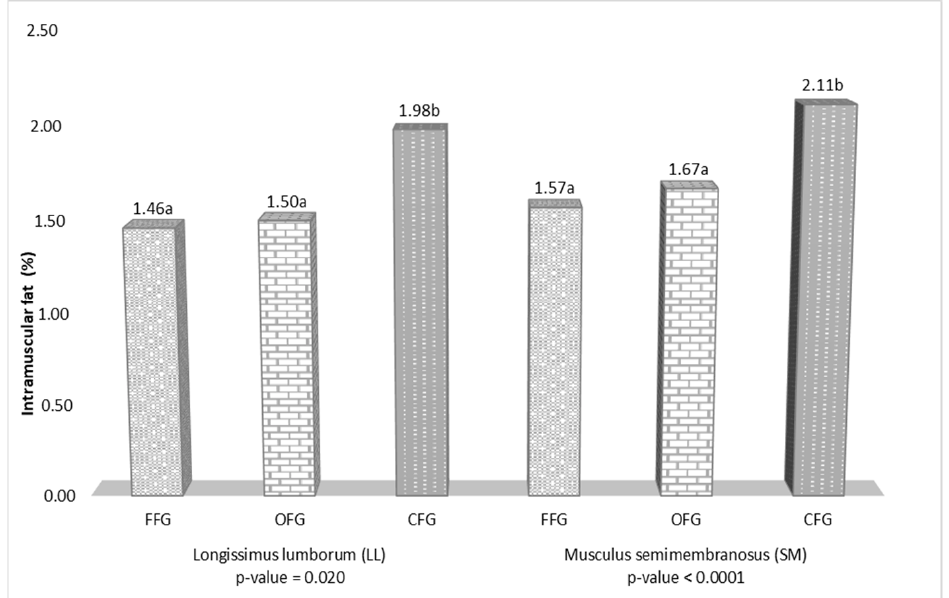
Figure 3. Content of intramuscular fat (%) in the meat of red deer from the three feeding grounds (FFG—forest feeding ground; OFG—organic feeding ground; CFG—conventional feeding ground). For each muscle, means in the same row sharing different letters are significantly different.